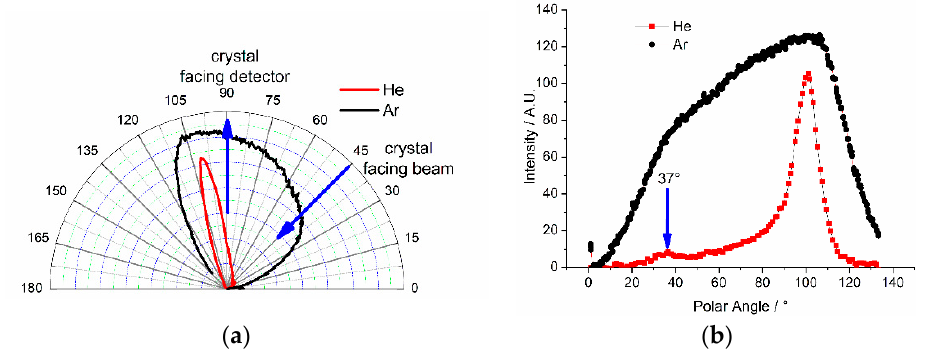
Figure 1. ( a ) Polar representation of the scattering of He and Ar from Pt(110), clearly showing the differences between the light and heavy inert gases. The latter has a much longer residence time on the surface and so becomes largely thermalized to the surface temperature. ( b ) The signal intensity is plotted as a function of crystal polar angle (Cartesian plot).